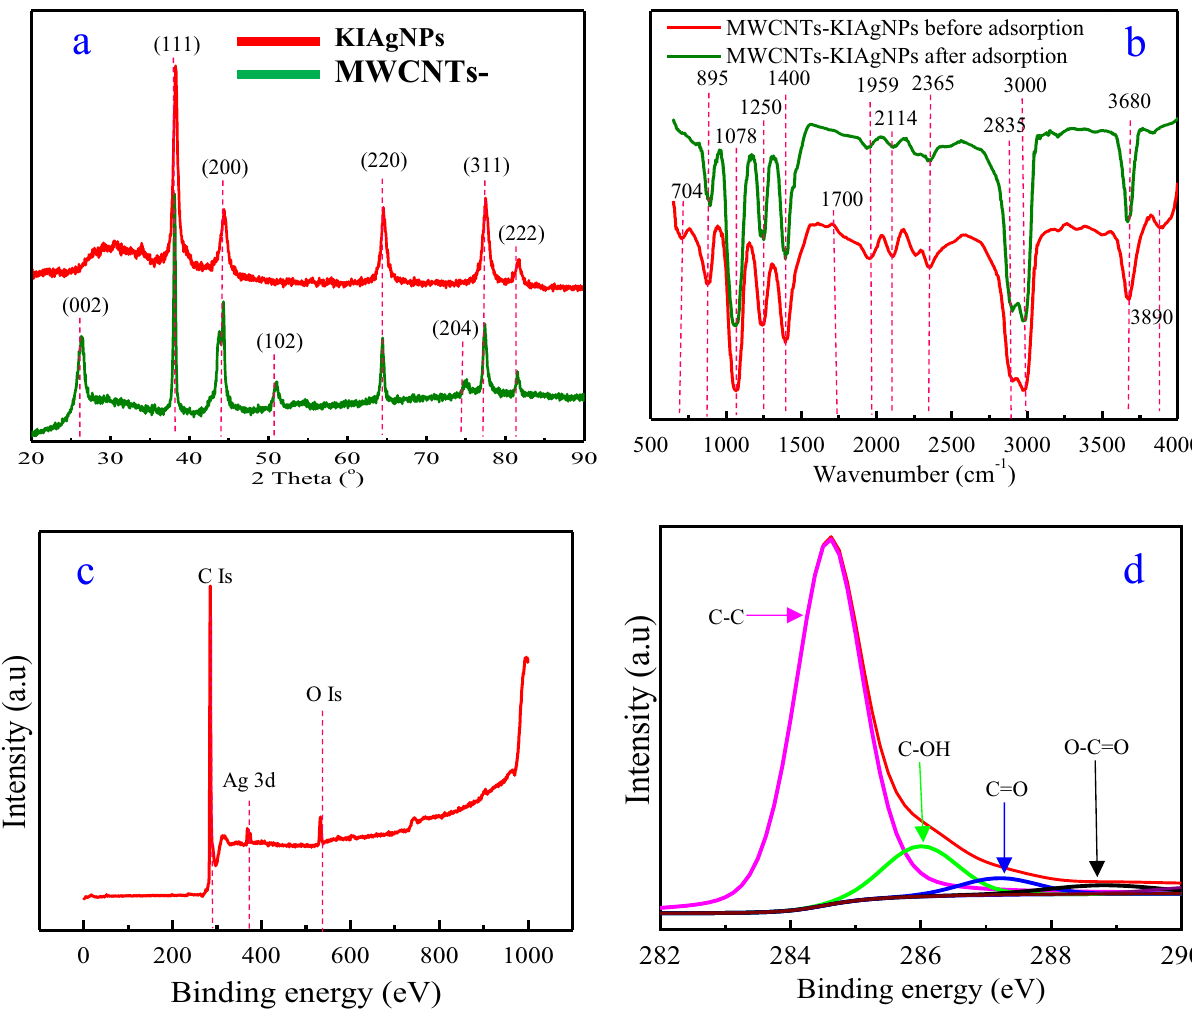
Figure 2. XRD of (a) KIAgNPs and MWCNTs-KIAgNPs; (b) FTIR of MWCNTs-KIAgNPs before and after adsorption; (c) XPS full survey scan spectra of MWCNTs-KIAgNPs; (d) high resolution C 1s spectra of